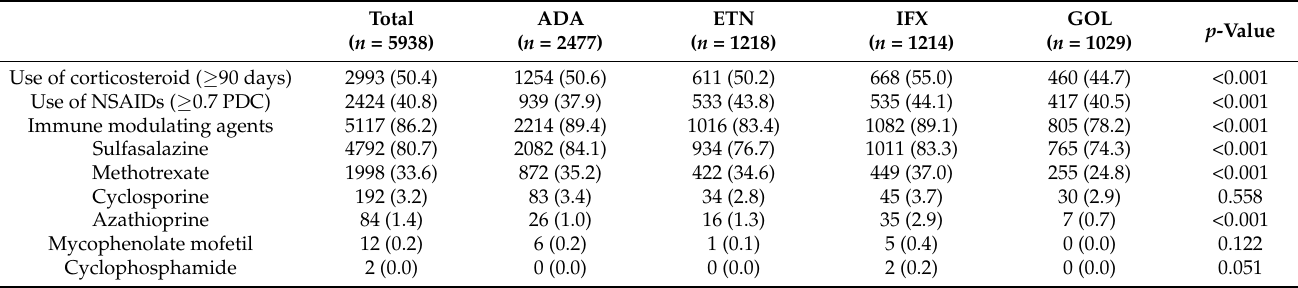
Table 2. Use of concomitant medications with TNF- α inhibitor use.